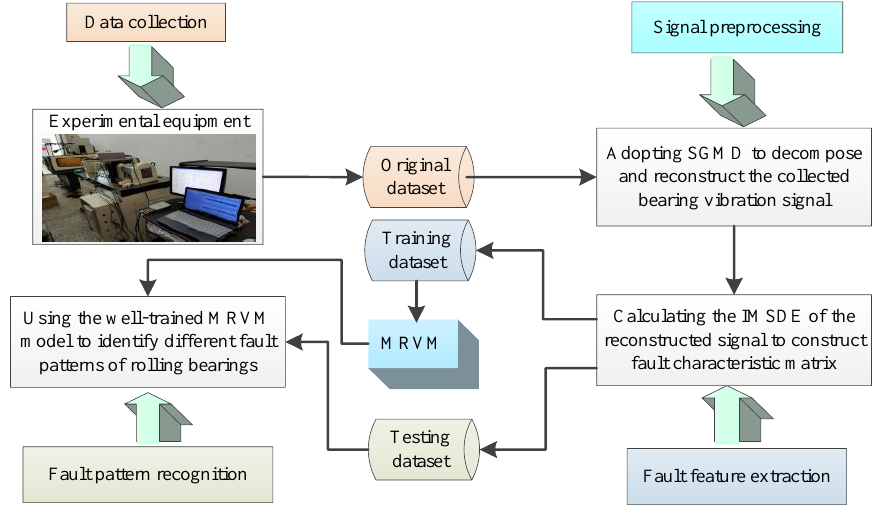
Figure 8. Flowchart of the proposed method for bearing fault identification.